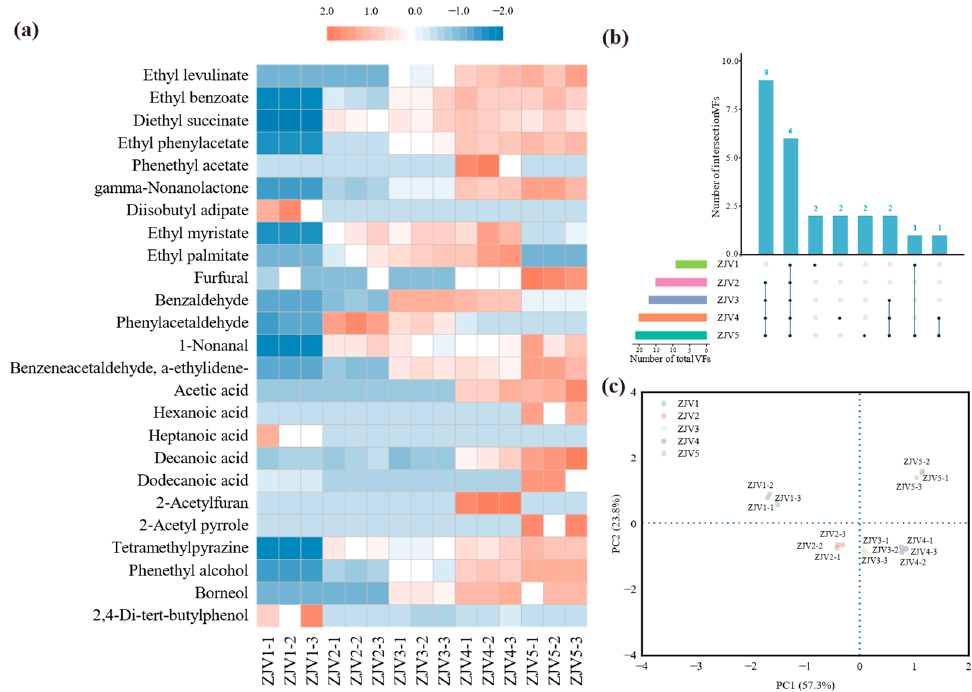
Figure 2. ( a ) Heat map of flavoring substances and microbial correlation. ( b ) UpsetR diagram representing shared and unique flavor substances during fermentation. ( c ) Principal component analysis of volatiles in five fermentation stages.